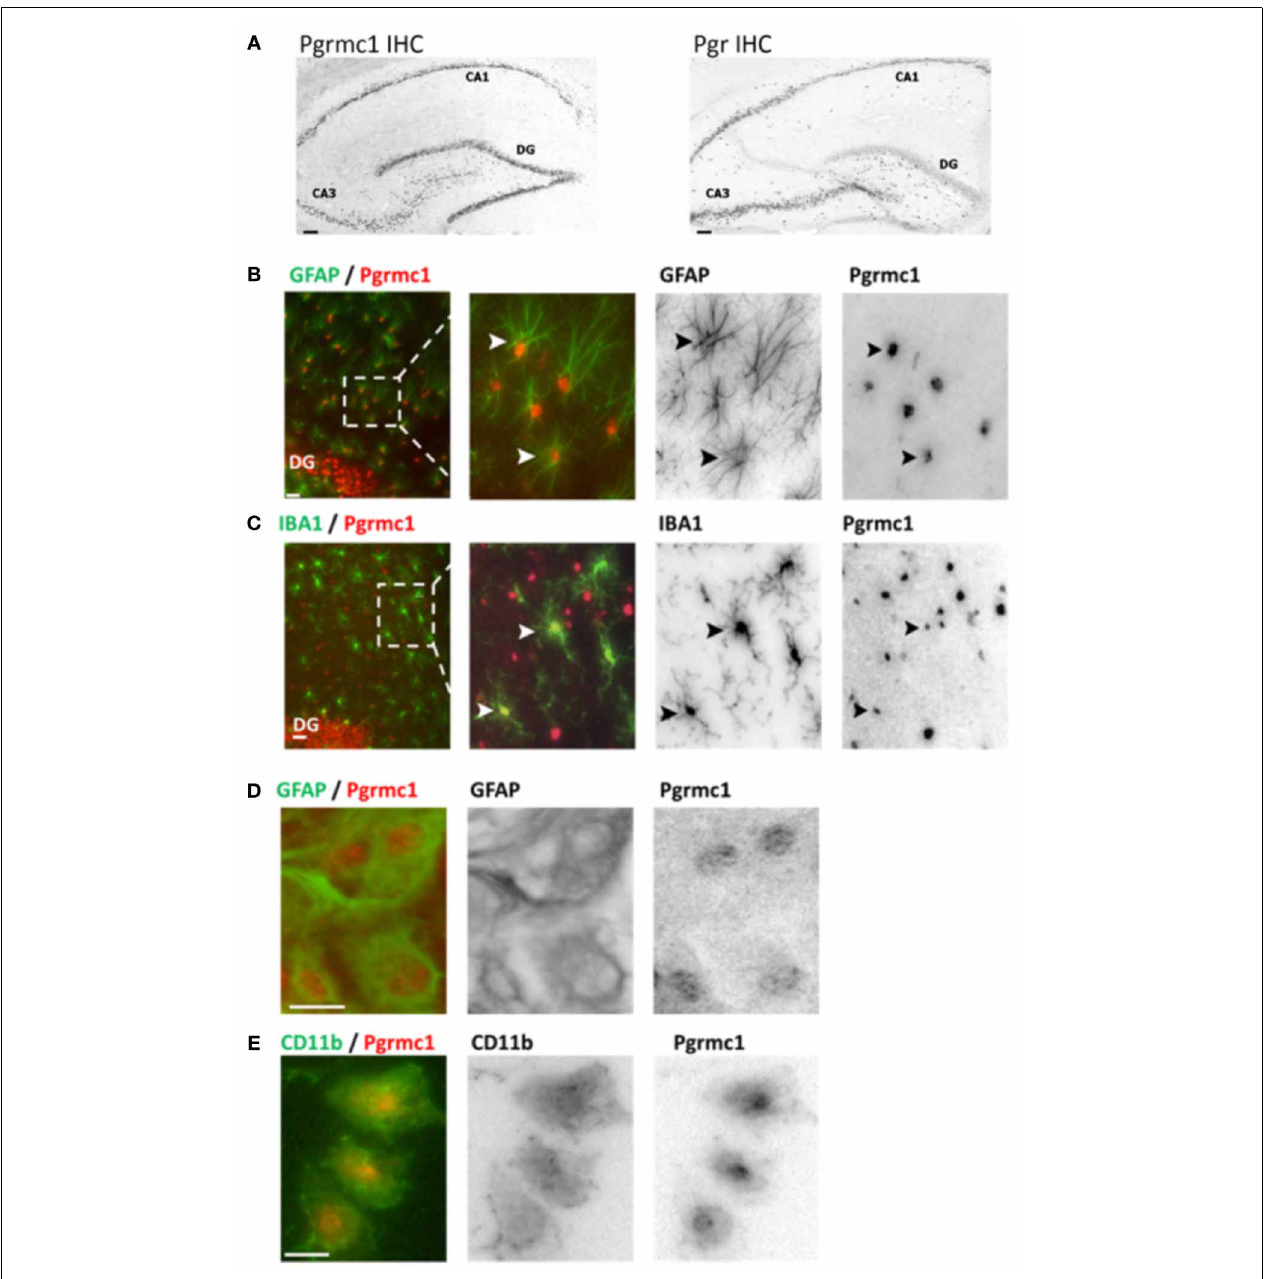
FIGURE 1 | Pgrmc1 and Pgr (PR) expression in rat brain glia and neurons by immunocytochemistry. (A) Neuronal Pgrmc1 and Pgr expression in adult rat hippocampus was equivalent in the hippocampus CA1, CA3, and dentate gyrus (DG) layers. In contrast, neuronal Pgr expression was lower DG vs. CA1 and CA3 layers. (B) Astrocyte Pgrmc1 in DG molecular layer co-stained with GFAP.